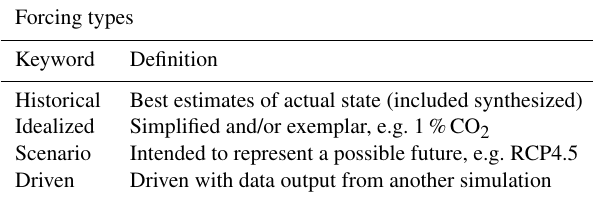
Table 2. ES-DOC forcing types controlled vocabulary; provides context for a forcing